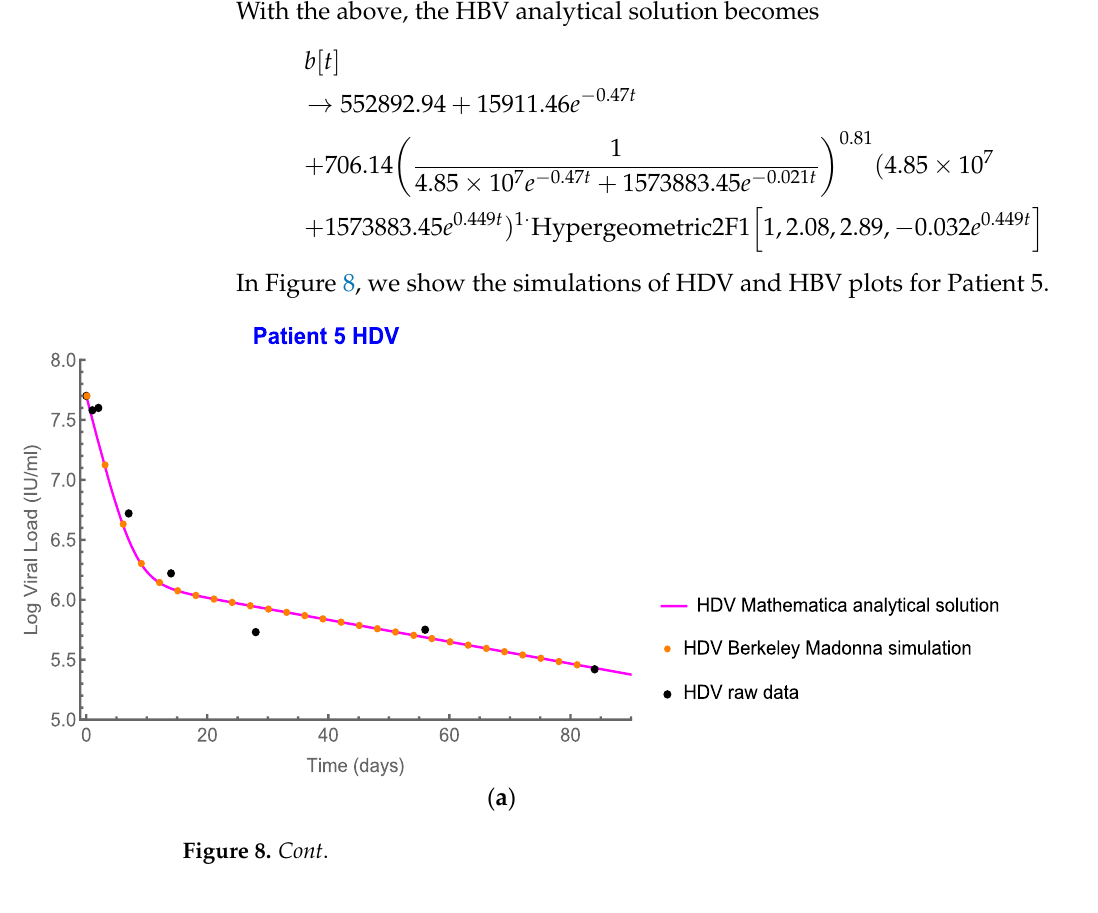
( b ) Figure 8. ( a ) shows the HBV Mathematica analytical solution (i.e., Equation (16) herein), HBV Berke- ley Madonna fit for patient 5, which was a result of fitting the modified model with measured data using Berkeley Madonna 8. ( b ) follows a similar approach as conducted in 8a but for HDV using D. 5. Discussion and Conclusions In this study, we provided additional insights into the interplay between HDV and HBV during anti-HDV treatment by suggesting a modification to our recently published mathematical model [4]. The modification was achieved by replacing the term n − 4 (D 0 /D(t)) n in Equation (2) with a new term (1+(k/D) n ) as shown in Equation (5). The term (1+(κ/D) n ) allowed starting with a pre-treatment HBV production rate, which could in- crease as a result of HDV decline by the several suggested mechanisms that were re- viewed in [18] . The value of κ, which was unique for each patient (Figure 4), could repre- sent, in part, the interplay between HDV and HBV. The modified model could explain HDV decline with different HBV kinetic changes: (i) no change (Figure 4a), (ii) a delay followed by an increase (Figure 4b,d), and (iii) a fast